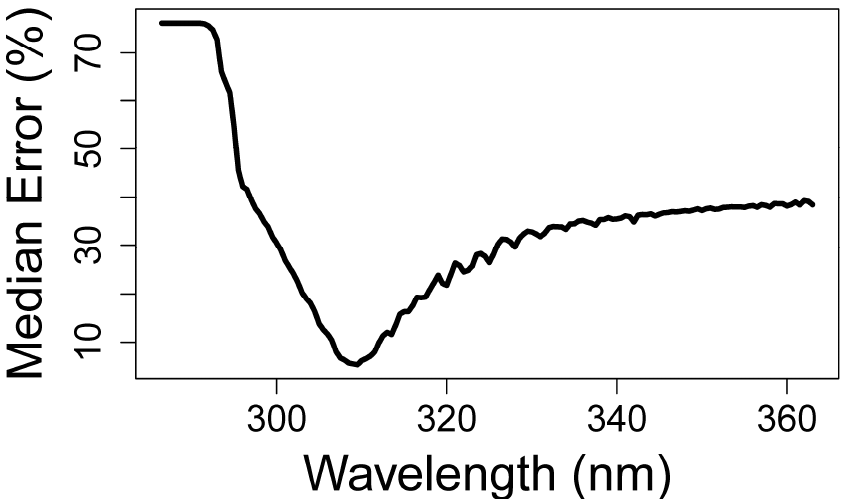
Figure 2. The median percent error in UVI prediction across all 405,000 UV–Net spectra, modeled as an ideally calibrated linear single-wavelength detector as a function of the detector wavelength. There is a sharp and narrow band of low error at 310